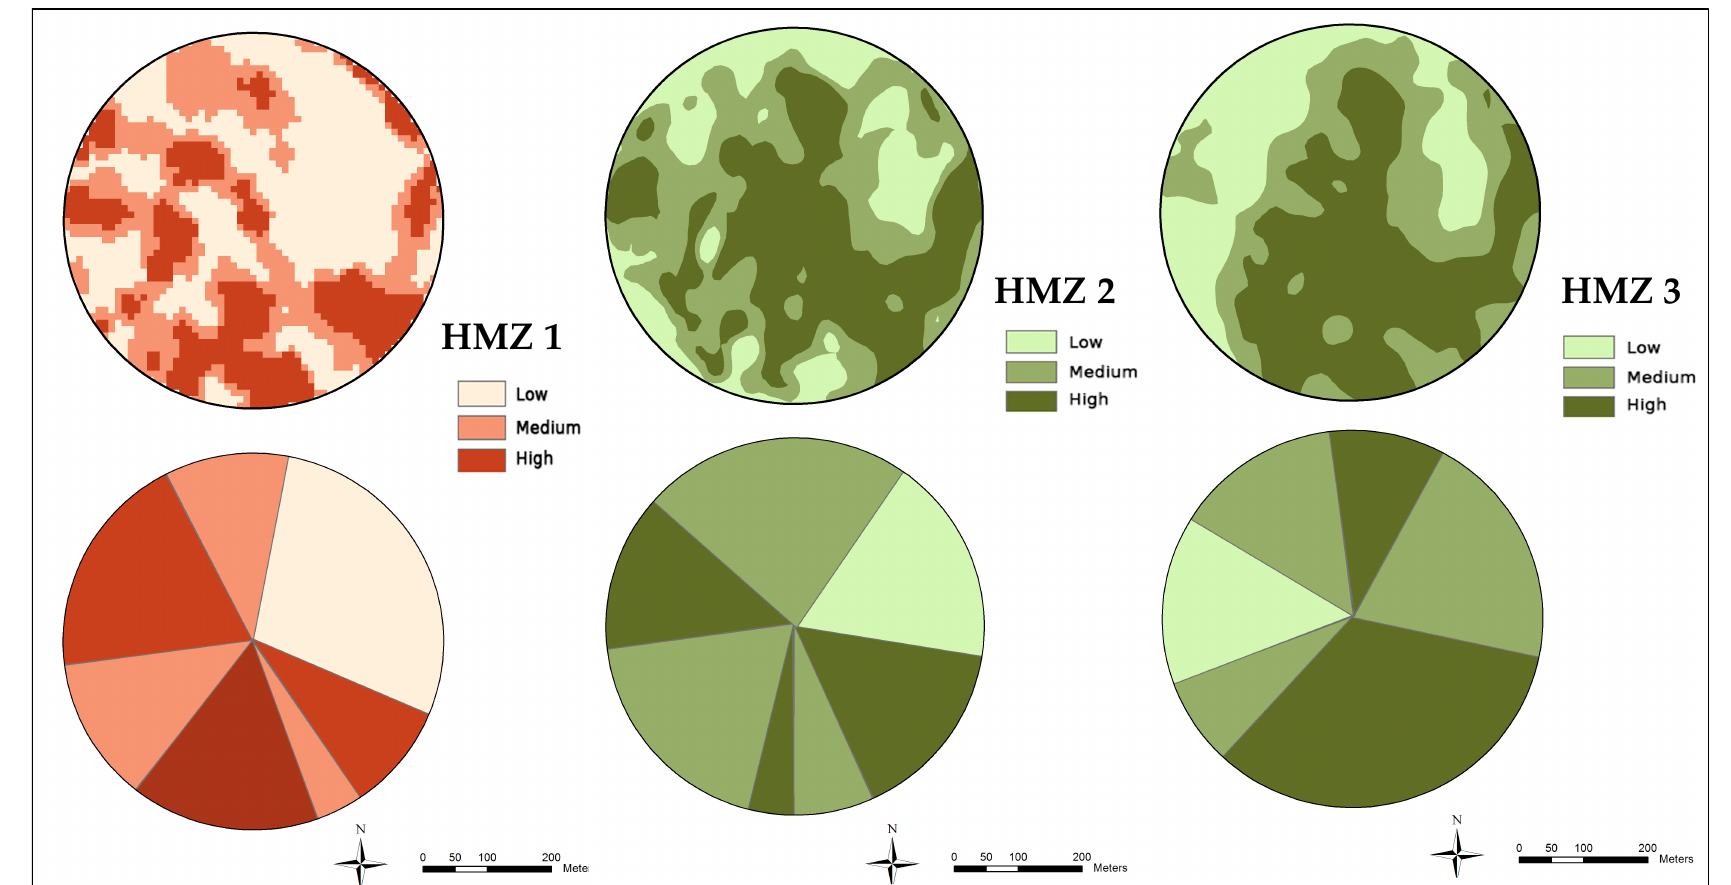
Figure 9. Homogeneous management zones (HMZ) maps 1, 2, and 3 (left) and the correspondent maps converted into the pie slice format (right).